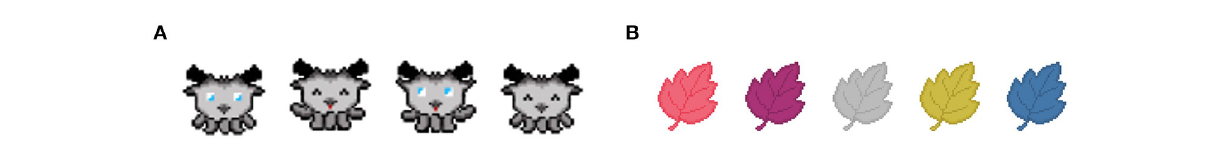
FIGURE1 Integral components of the Alien Zoo framework: (A) An exemplary group of shubs, the small alien species inhabiting the zoo. (B) Plants available to the participants for feeding.